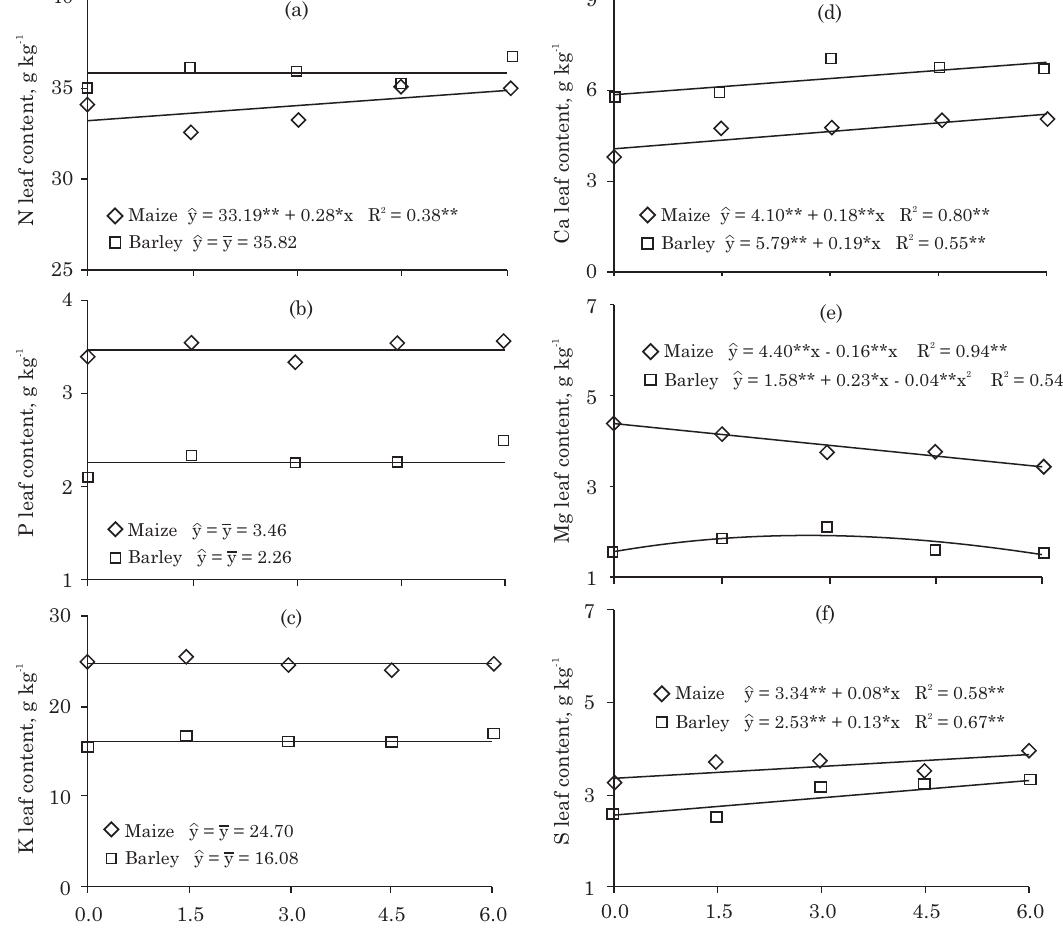
Figure 4. Leaf tissue content of nitrogen (N), phosphorus (P), potassium (K), calcium (Ca), magnesium (Mg), and sulfur (S) in maize and barley crops as a function of gypsum rates applied on the soil surface under a no-till system. * p<0.05 and **